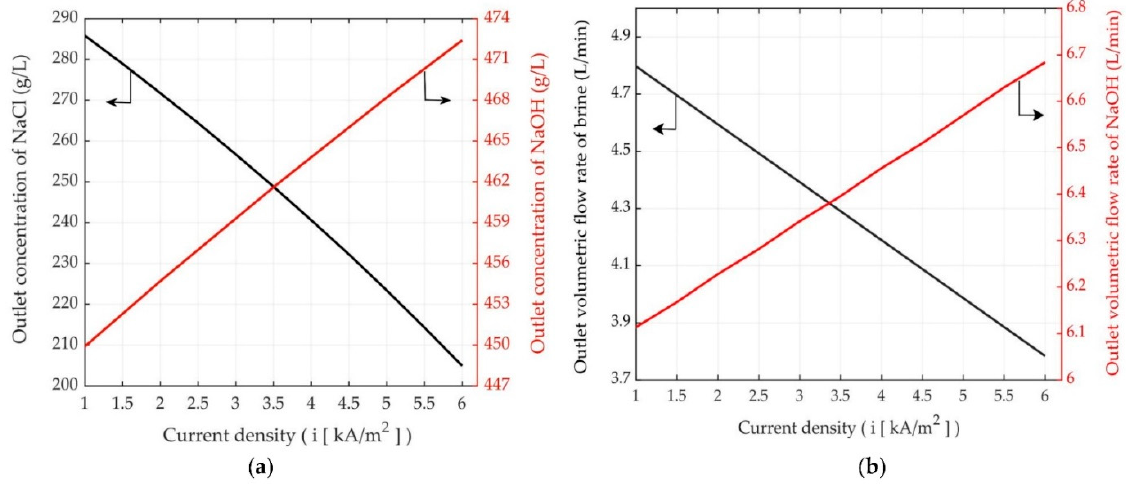
Figure 5. The outlet concentration as well as volumetric flow rate of electrolytes as a function of current density from 1 to 6 kA m (cid:2879)(cid:2870) . ( a ) Concentration of electrolytes and ( b ) volumetric flow rate of electrolytes. Operating conditions: temperature: T (cid:2911)(cid:2924)(cid:2919)(cid:2924) = T (cid:2913)(cid:2911)(cid:2930)(cid:2919)(cid:2924) = 85 °C ; electrolyte concentration: electrolytes. Operating conditions: temperature: T in an = T in cat = 85 ◦ C; electrolyte concentration: X (cid:2911)(cid:2924),(cid:2898)(cid:2911)(cid:2887)(cid:2922)(cid:2919)(cid:2924) = 300 gL (cid:2879)(cid:2869) and W (cid:2913)(cid:2911)(cid:2930),(cid:2898)(cid:2911)(cid:2899)(cid:2892)(cid:2919)(cid:2924) = 31 wt% ; inlet volumetric flow rate: Q(cid:4662) (cid:2911)(cid:2924)(cid:2919)(cid:2924) = 5 L min (cid:2879)(cid:2869) and Q(cid:4662) (cid:2913)(cid:2911)(cid:2930)(cid:2919)(cid:2924) X in = 300 gL − 1 and W in = 31 wt%; inlet volumetric flow rate: = 6 L min (cid:2879)(cid:2869) . can, NaOH an, NaCl . in − 1 Q cat = 6 L min